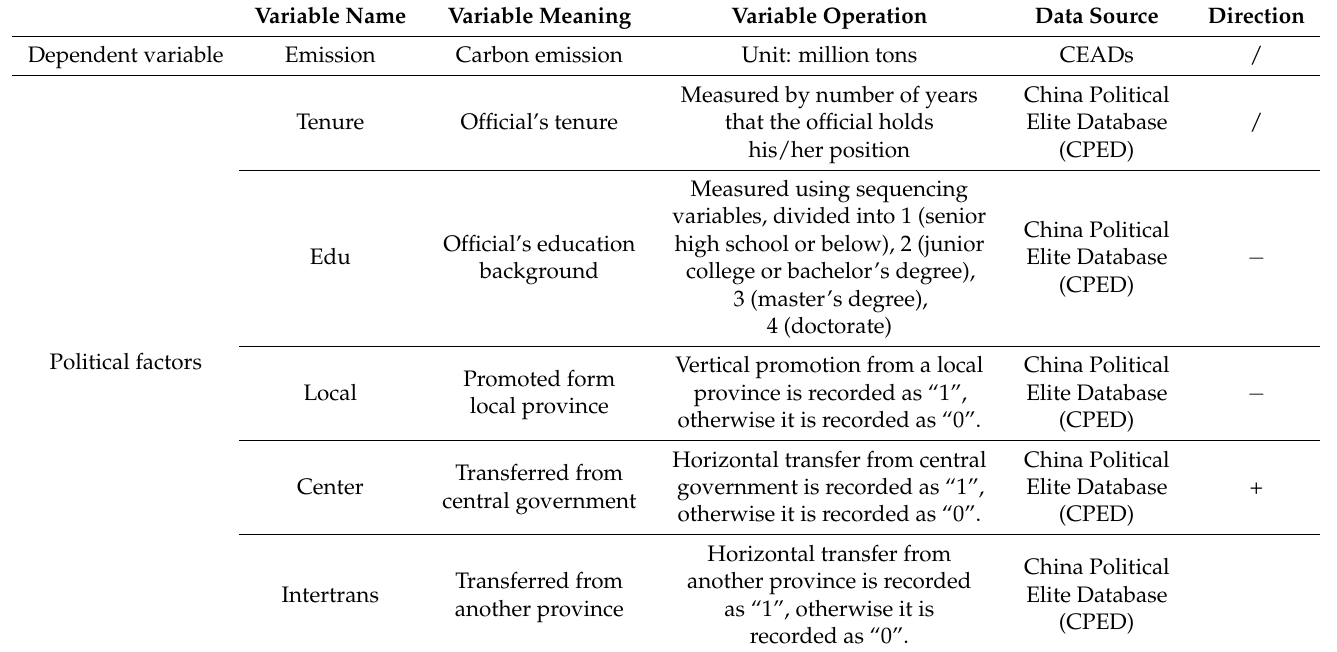
Table 1. Definitions of variables of used to measure the effectiveness of China’s carbon emissions trading system and their measurement